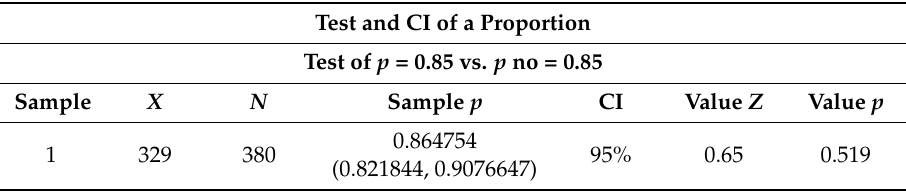
Table 1. Statistical inference in Minitab 16.0, level of